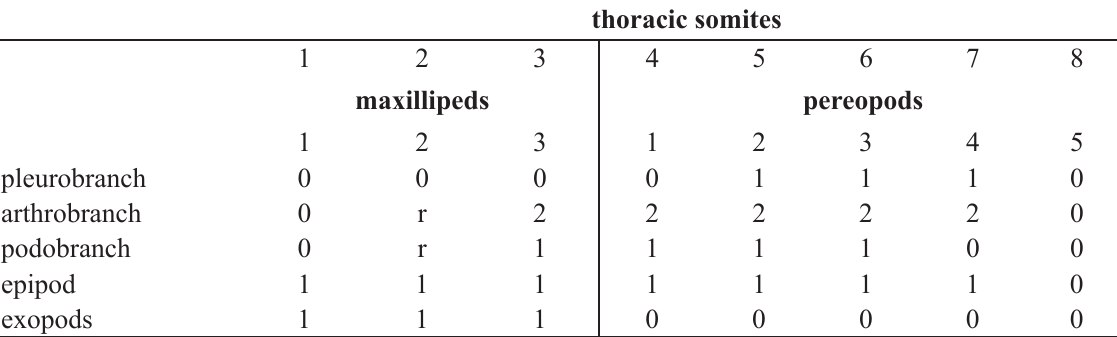
European Journal of Taxonomy 229: 1–11 Table 1. Gill formula of Montaxius mediumquod gen.et sp. nov.; r = rudimentary.